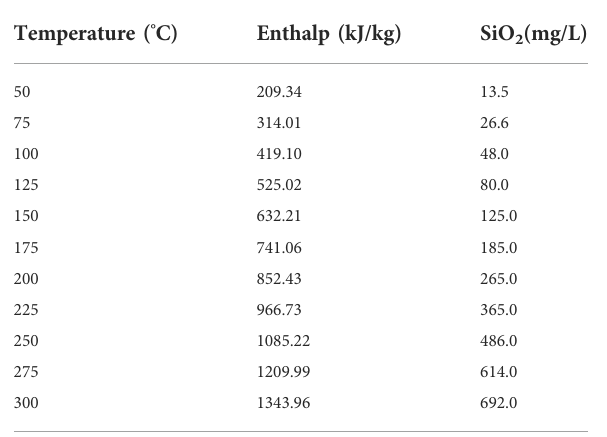
TABLE 7 The relationship between geothermal fl uid temperature and silica and enthalpy content.